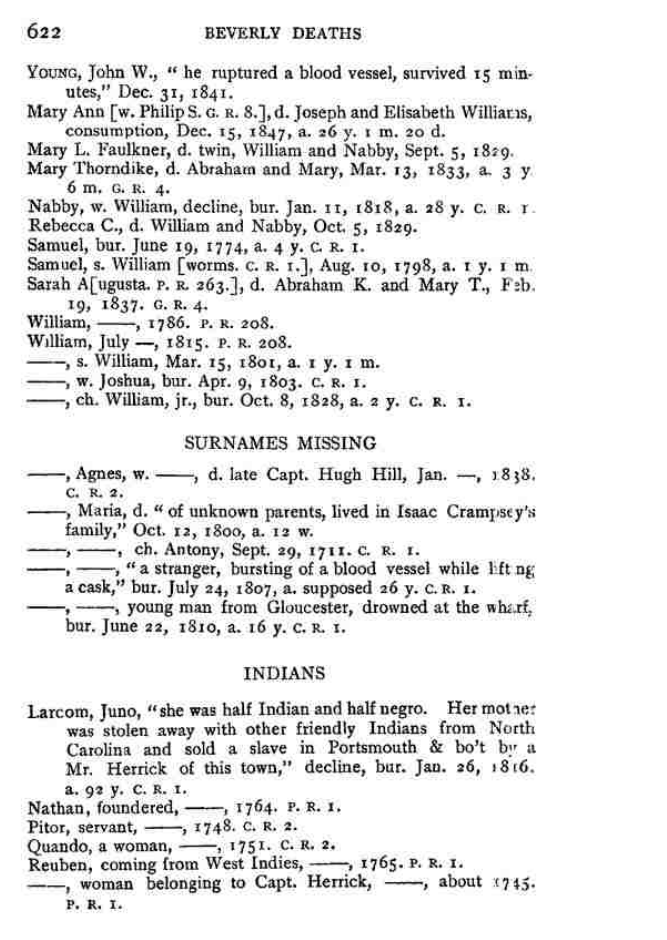
Figure 2. Scan from Massachusetts Vital Records, Beverly, Negro Deaths to 1849, of Juno Larcom’s death record, p. 622.